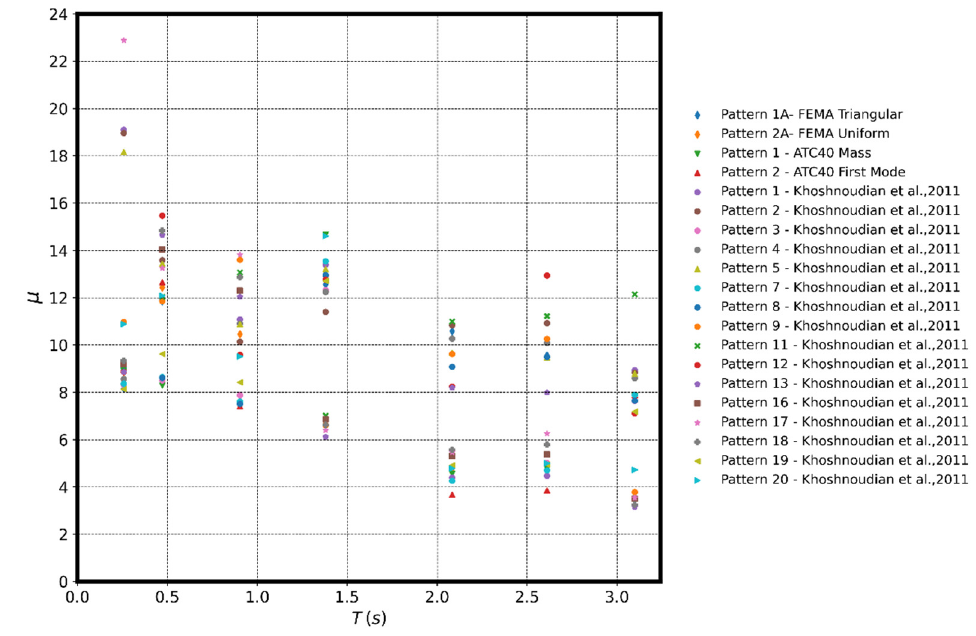
Figure 9. Ductility factor versus period for different